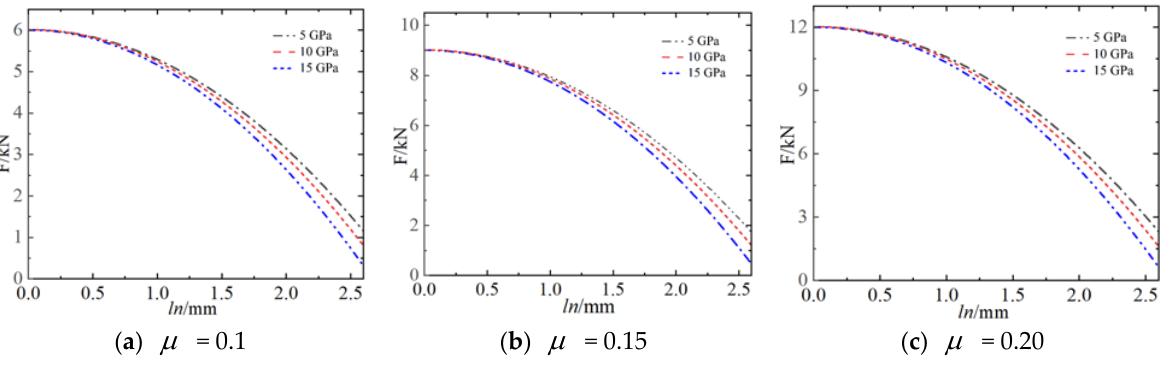
Figure 9. Stick–slip critical length and critical force curve.